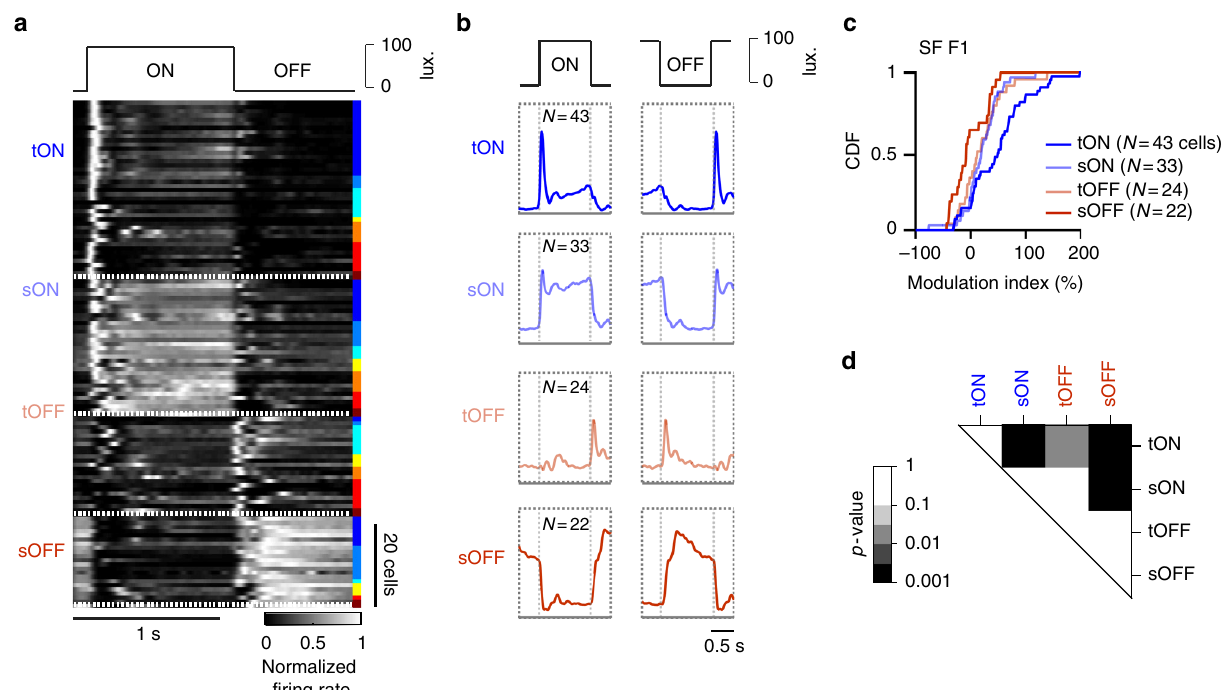
Fig. 8 Preferential modulations of dLGN neurons with transient-ON responses. a Grouping of dLGN cells ( N = 122) based on cycle averages in response to full- fi eld contrast reversal stimulus (150 – 200 trials). Classi fi cation into four groups: transient ON, N = 43 cells (blue); sustained ON, N = 33 cells (light- blue); transient OFF, N = 24 cells (light red); and sustained OFF, N = 22 cells (red). Right inlet relates to which experiment each neuron was recorded ( N